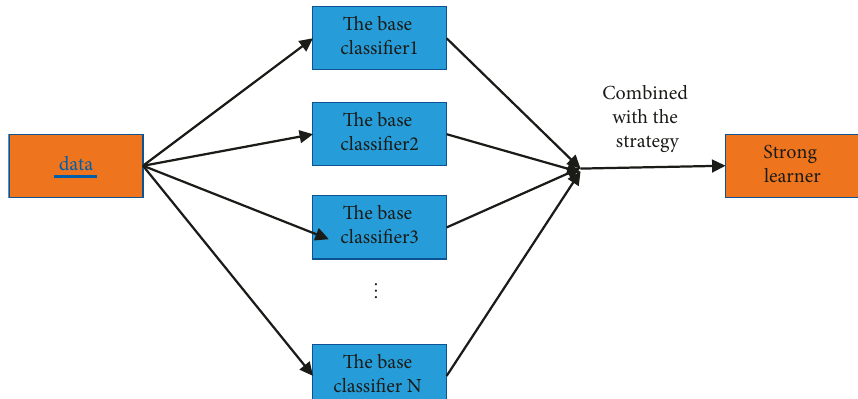
Figure 1: Block diagram of integrated learning